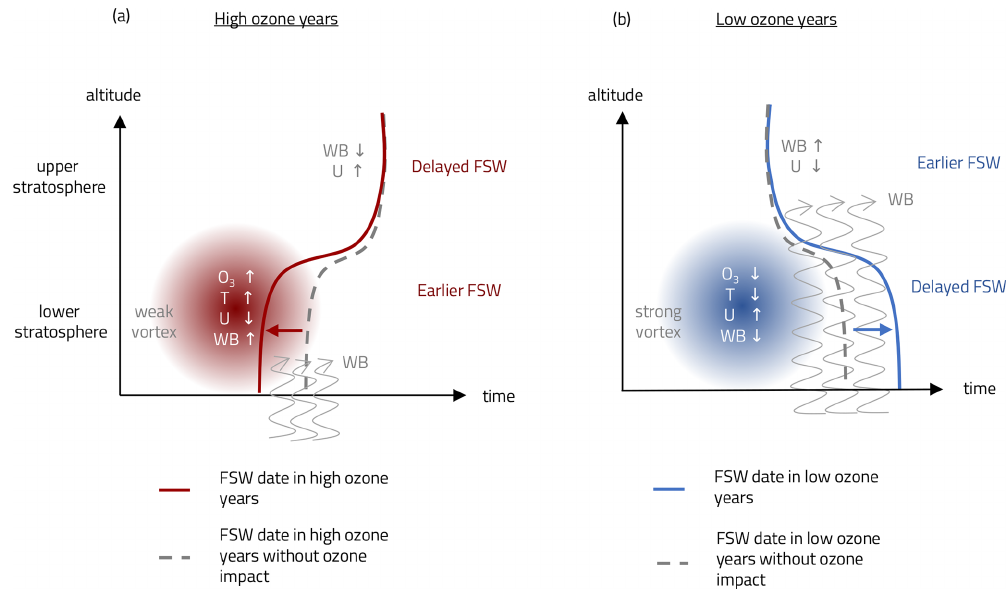
Figure 10. Ozone feedback mechanism around the FSW date. Dashed grey lines indicate the dipole structure of the FSW date without ozone impact (as in the CLIM-3D setting), i.e., merely as a result of a weak or strong polar vortex and subsequent implications for wave breaking (WB) in the upper stratosphere. Impacts of ozone anomalies on temperature ( T ), zonal wind ( U ) and WB acting on top of the dynamical processes around the FSW date are highlighted in red (a) and in blue (b) for low- and high-ozone years, respectively. The red and blue arrows show the subsequent shift in the timing of the FSW induced by ozone. The resulting FSW date is schematically shown by the thick red line (high-ozone springs) and the thick blue line (low-ozone